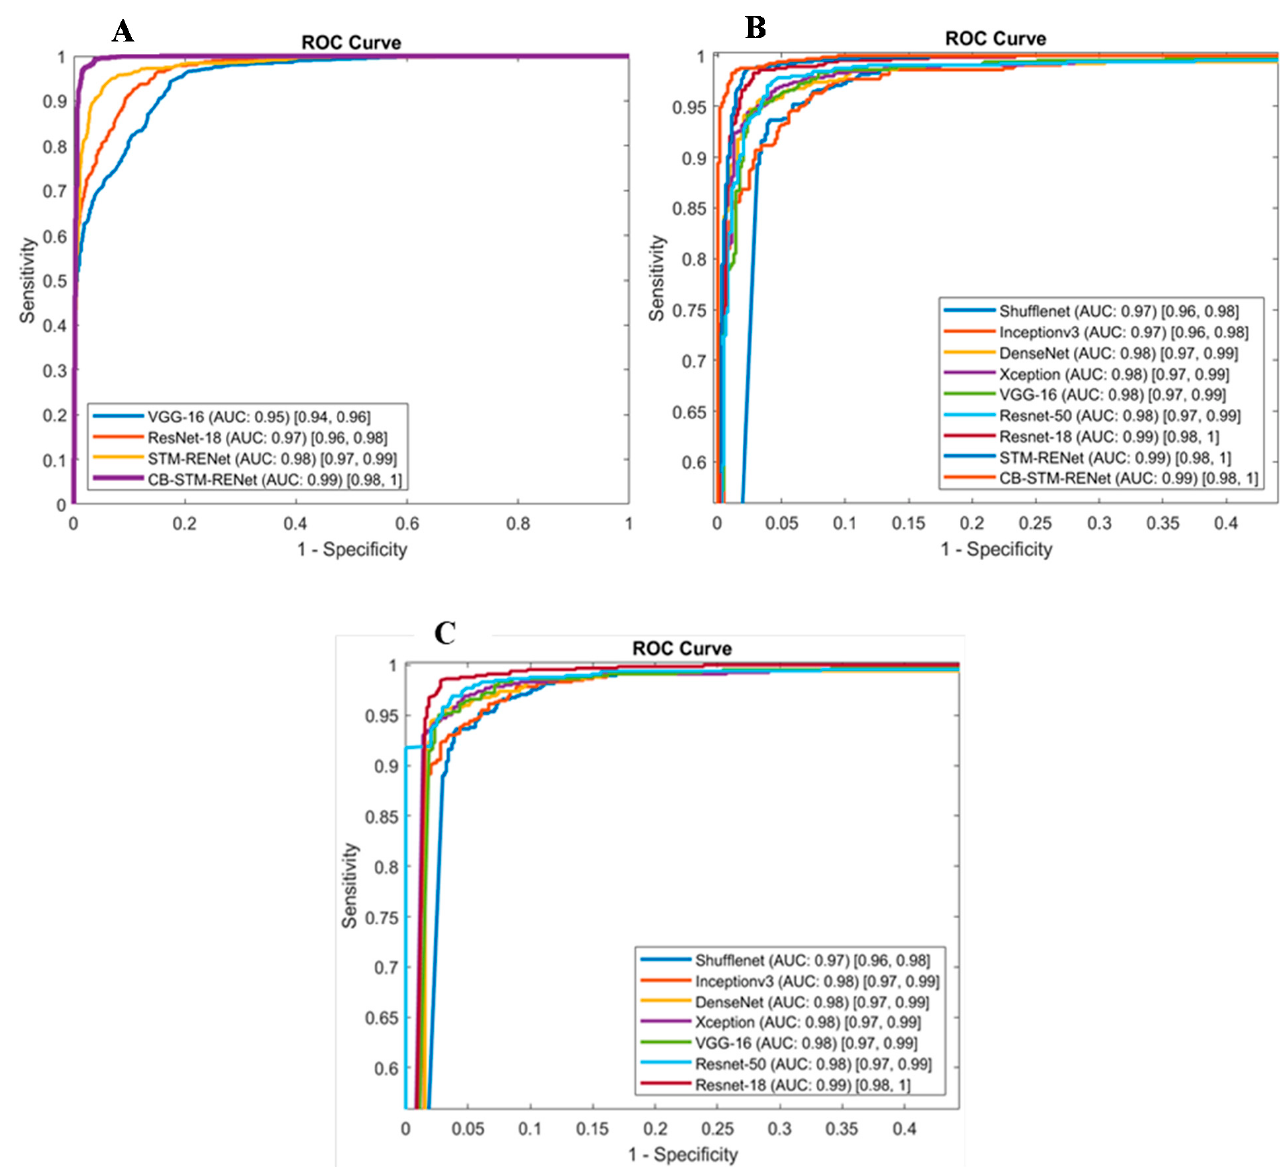
Figure 12. ROC Curve for the proposed STM-RENet, CB-STM-RENet, and existing CNN techniques. ( A ) is reported for CoV-NonCOV-10k, while ( B , C ) for CoV-Healthy-6k. ROC in ( C ) is reported for TL-based CNN architecture. AUC CI at 95% is shown in square brackets.